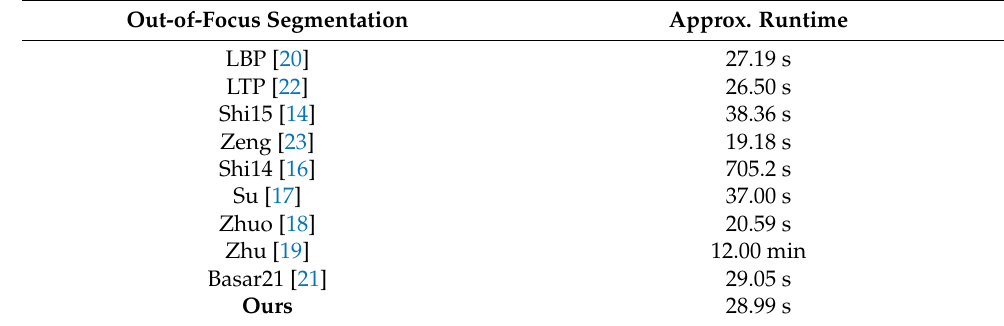
Table 3. Comparative running time evaluation of numerous approaches. The time of the proposed scheme is based on PCNN and LTP